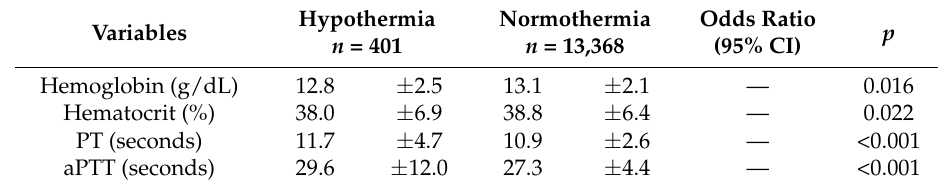
Table 2. Comparison of biochemistry between study groups.